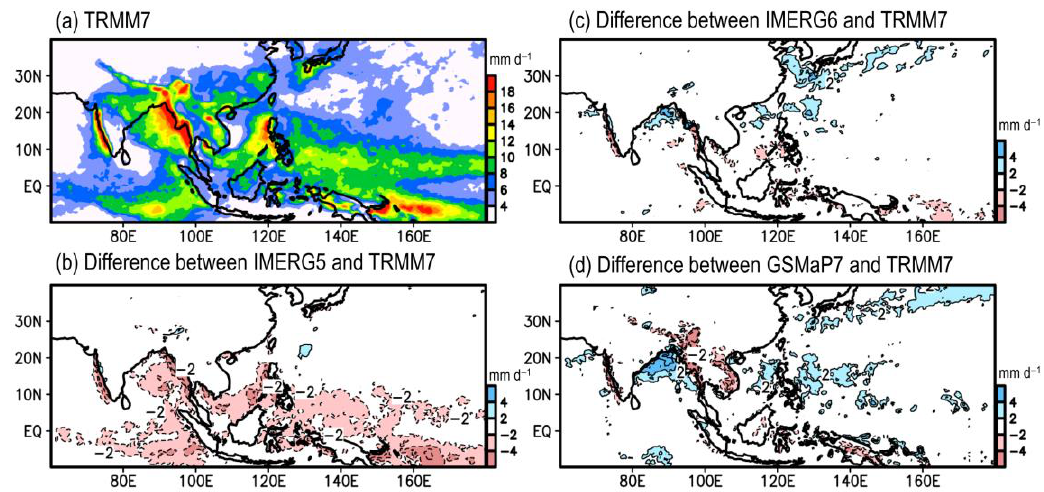
Figure 10. ( a ) Mean seasonal precipitation averaged during the summers of 2014–2017, estimated by TRMM7, over the Asian domain (60°E-180°, 10°S-40°N). ( b ) is related to ( a ), except for the difference between IMERG5 and TRMM7. ( c ) is similar to ( b ), except for the difference between IMERG6 and TRMM7. ( d ) is similar to ( b ), except for the difference between GSMaP7 and TRMM7.